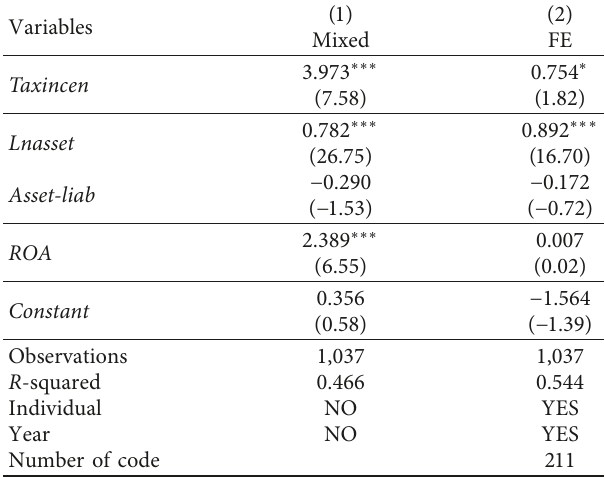
Table 3: Tax incentive policies-innovation input model.